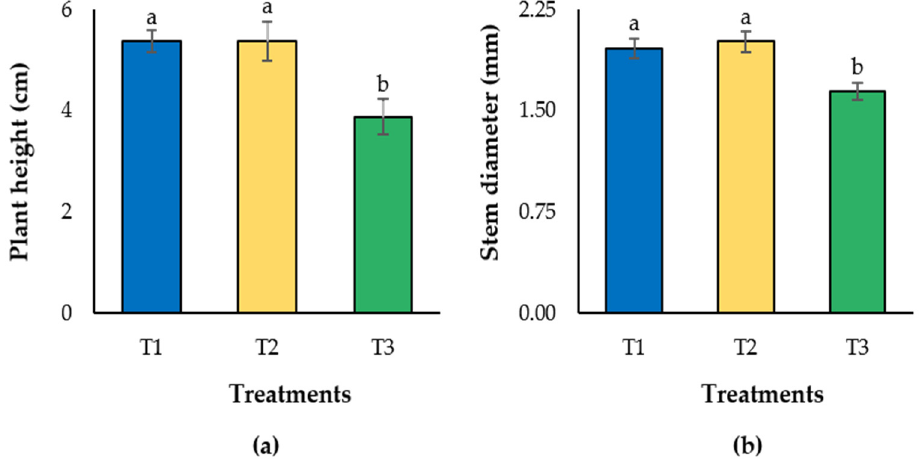
Figure 2. Plant height ( a ) and stem diameter ( b ) of lulo ( Solanum quitoense Lam.) seedlings grown in different combinations of peatmoss and compost. Columns are means of 10 seedlings per treatment randomly selected, one per repetition. Bars on the columns indicate standard deviation. Different letters on the columns indicate significant differences among treatments. Treatments are as follows (percentage of peatmoss/compost, v / v ): T1: 60/40; T2: 40/60; T3: 20/80.